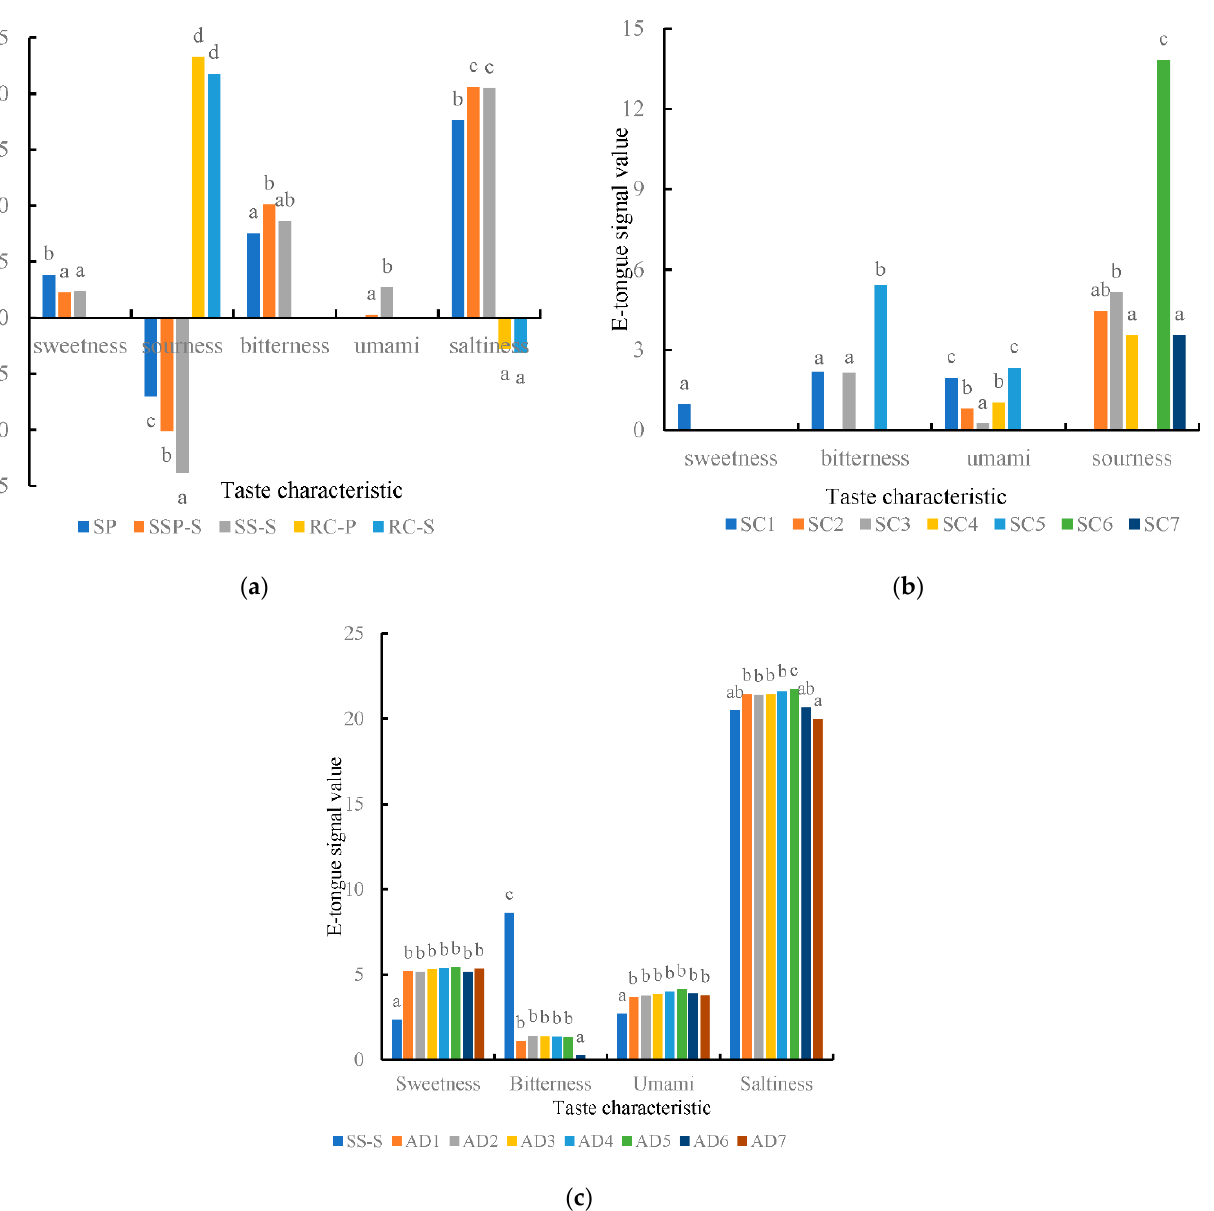
Figure 3. Electronic tongue analysis ( a ) analysis of different stewed samples; ( b ) analysis of standard compounds; ( c ) analysis of additional experiment). Letters (a, b, c) indicate significantly difference at p < 0.05 (Duncan